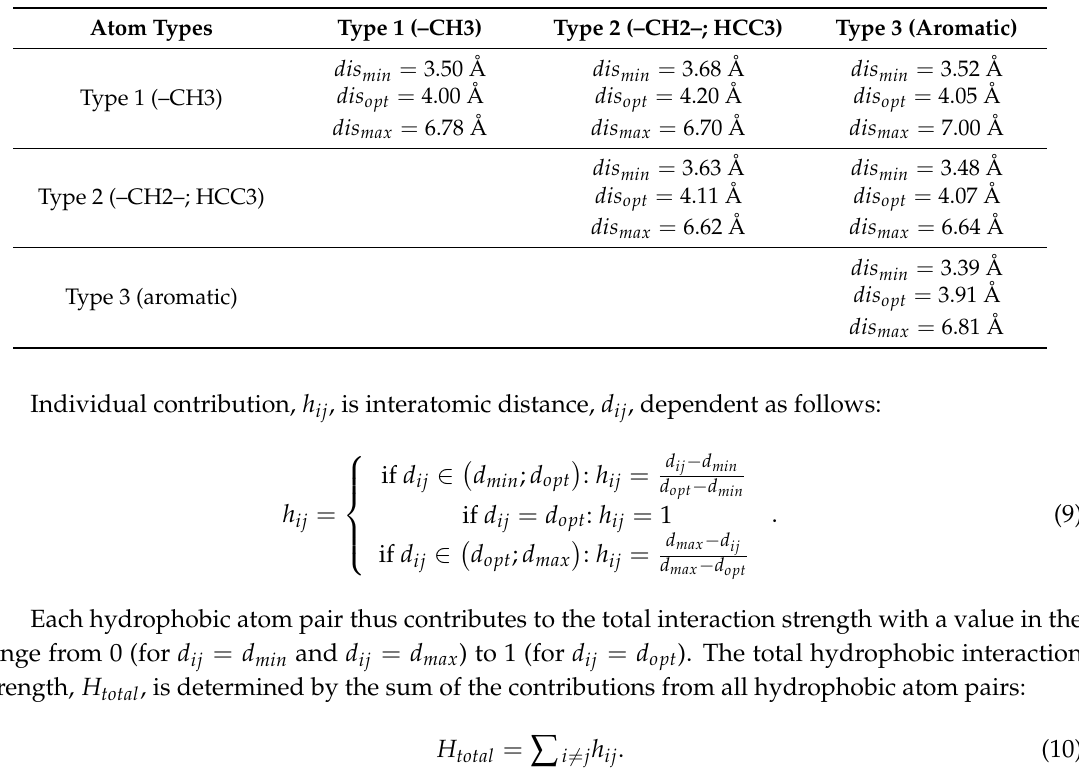
Table 3. The minimum, optimal, and maximum distances between interacting hydrophobic atoms utilized to determine interaction